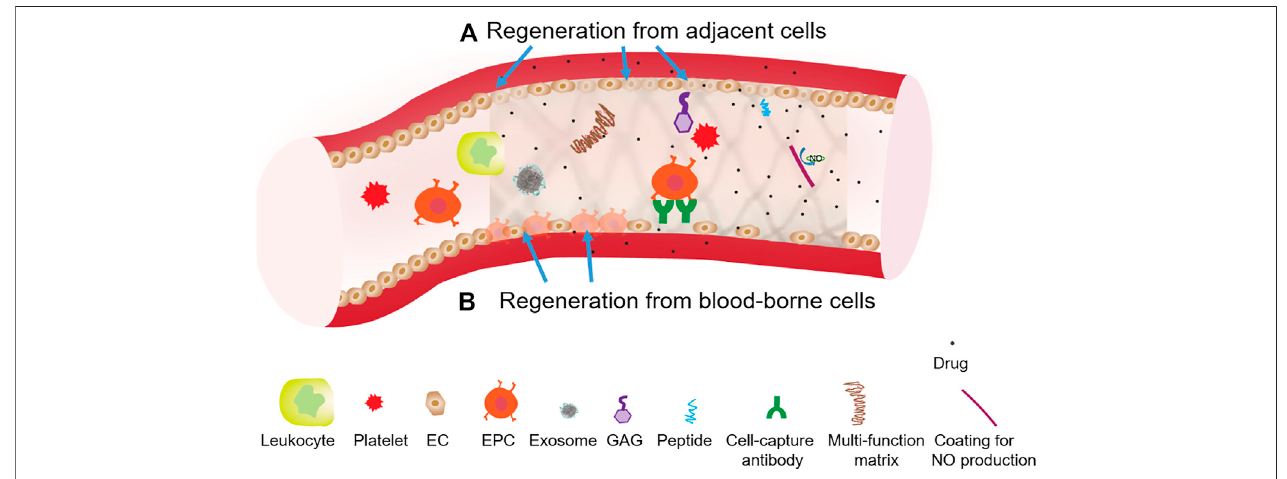
FIGURE 2 | Two generation mechanisms using surface functionalizations to override drug inhition effects on stent endothelialization. (A) Regeneration from adjacent cells, which can involve the functionalization of stents with angiogenic peptide or NO producing coating. (B) Regeneration from blood-borne cells, which can involve the functionalization of stents with certain cell-capture antibodies, adhesive peptide or growth